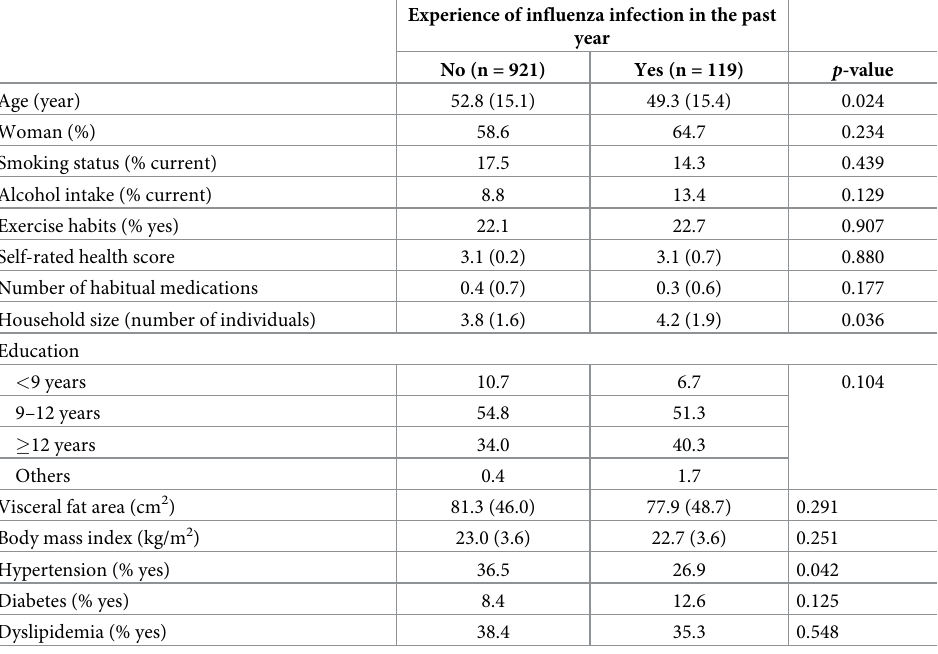
Table 1. Participant characteristics classified based on experience of influenza infection in the past